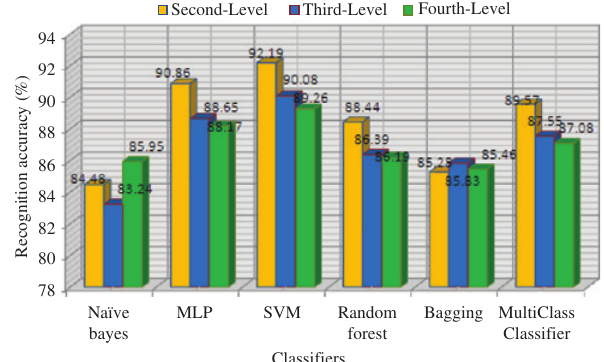
Figure 5: Graph Showing the Recognition Accuracies of Modified Log-Gabor Filter-Based Feature Extraction Method for Second- Level, Third-Level, and Fourth-Level Decomposition Approaches Using Six Different